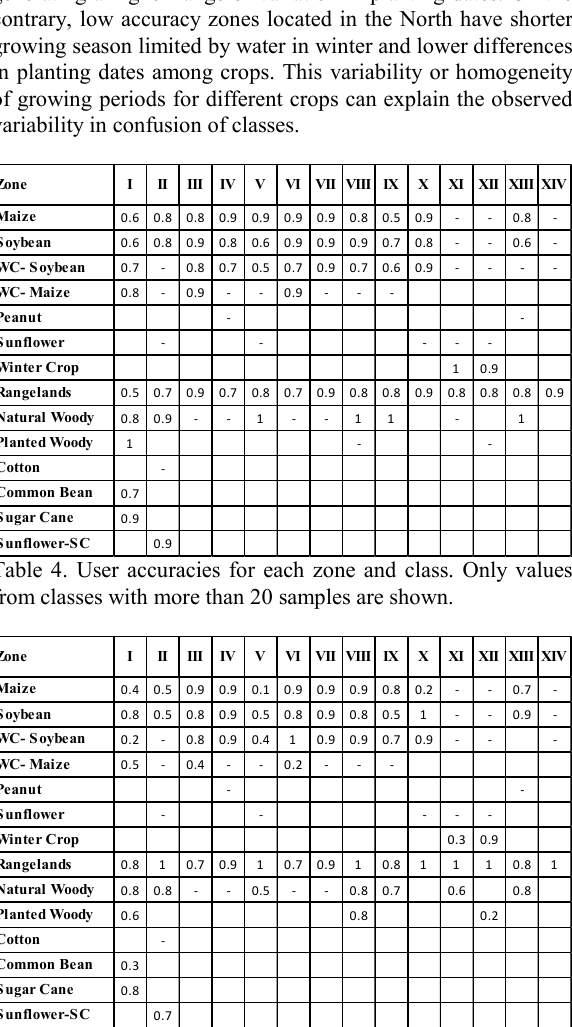
Table 5. Producer accuracies for each zone and class. Only values from classes with more than 20 samples are shown.